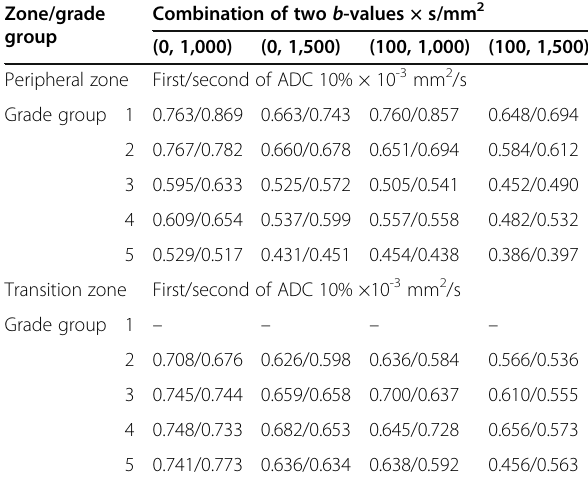
Table 2 Summary of the breakdown of ADC 10% according to grade group and the b -value combination in peripheral